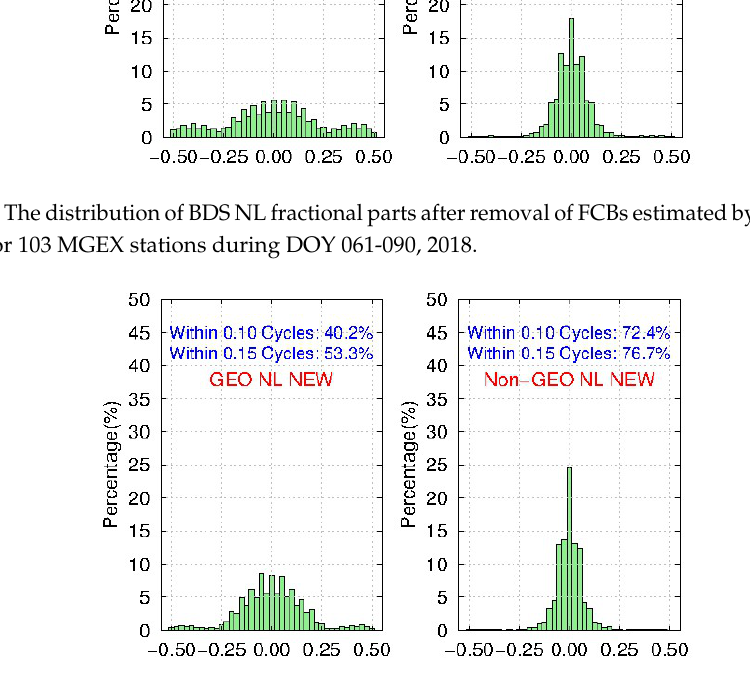
Figure 16. The distribution of BDS NL fractional parts after removal of FCBs estimated by the new strategy for 103 MGEX stations during DOY 061-090, 2018.